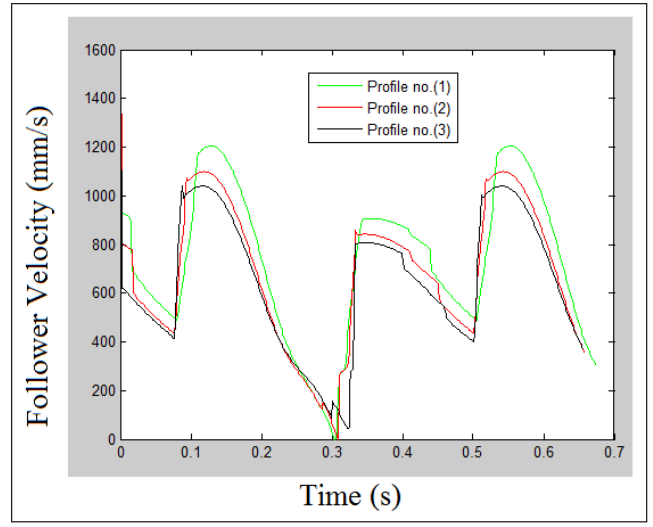
Figure 5. Velocity against time for the three involutes’ profiles of the cam.